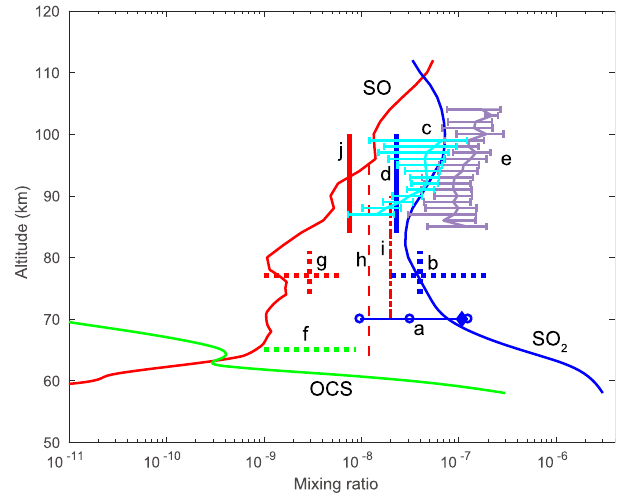
Fig. 1 Modeled pro fi les of SO2, OCS, and SO. Comparison of modeled pro fi les of SO 2 , OCS and SO with observations for SO 2 = 3.0 ppm and OCS = 0.3 ppm at 58 km, the lower boundary of the model. Model pro fi les are shown as thin solid lines: (blue) SO 2 , (green) OCS, (red) SO. Data sources: a SO 2 , interquartile range from 2006 through 2009, diamond shows mean of distribution, ref. 10 ; b SO 2 , ref. 11 ; c SO 2 , ref. 34 solar occultation with 1- σ error bars; d SO 2 , ref. 12 ; e SO 2 , ref. 34 stellar occultation with 1- σ error bars; f OCS, ref. 35 ; g SO, ref. 11 ; h SO, ref. 14 ; i SO, ref. 13 ; j SO, ref. 12